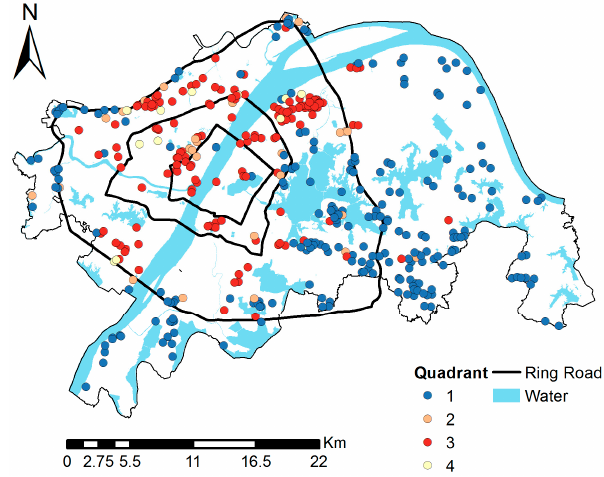
Figure 9. Quadrant spatial distribution of ESDI.